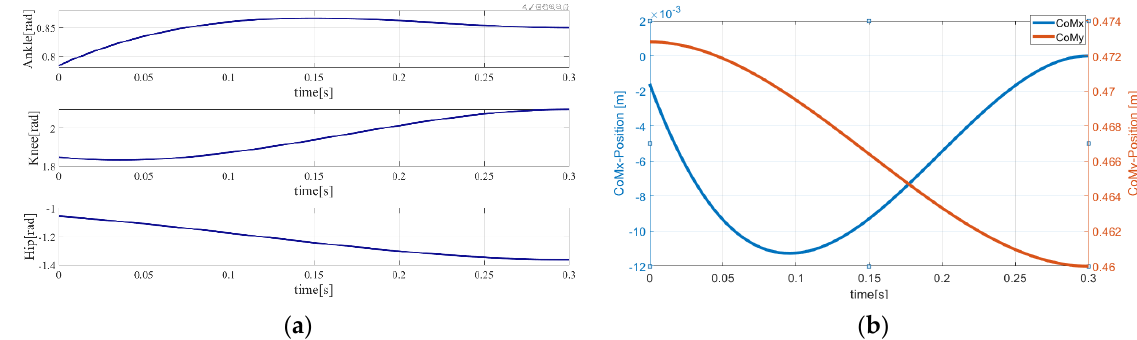
Figure 5. Trajectories of joints and CoM in landing phase. ( a ) Joint trajectories in the landing phase; ( b ) trajectory of CoM in the landing phase.